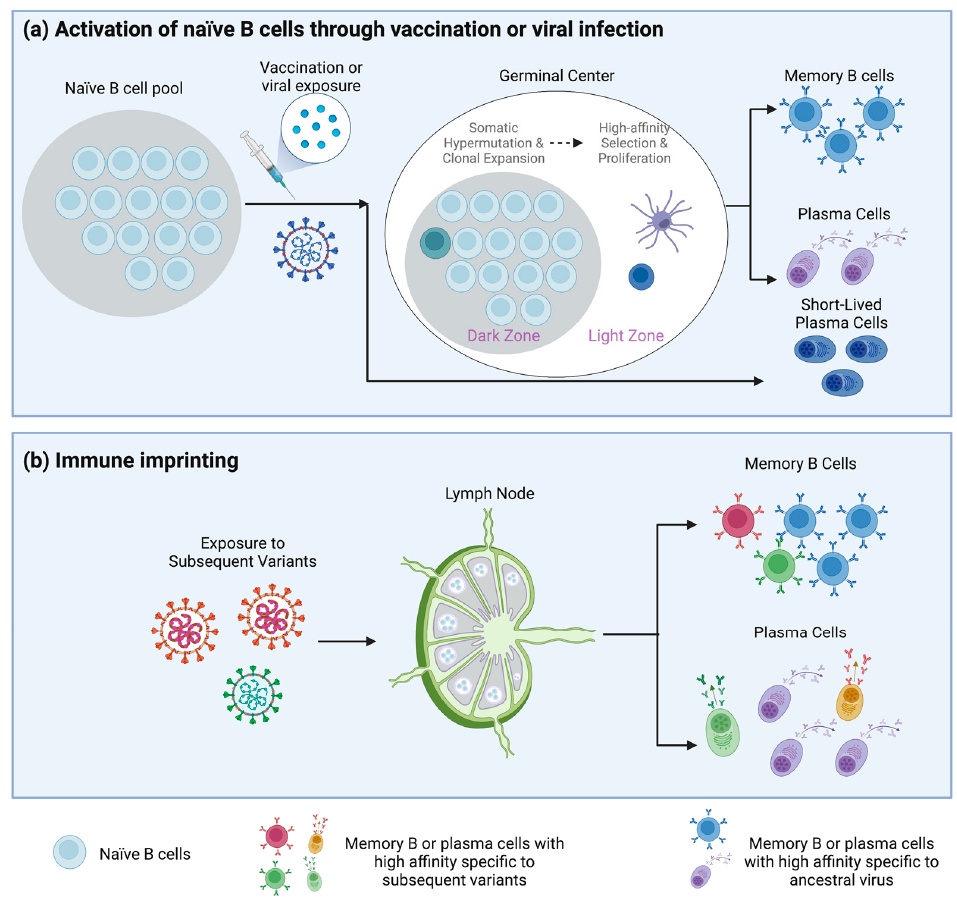
Figure 1. Establishment of B cell memory and immune imprinting. ( a ) Activation of memory B cells through vaccination or viral infection. Upon exposure to viral antigens by vaccination or infection, a germinal center starts to form. In the dark zone of the germinal center, optimal B cells with high-affinity BCR expressed on the surface can be selected for clonal expansion with the help of T FH cells and differentiate into long-term memory B cells and plasma cells. Some B cells can rapidly differentiate into short-lived plasma cells with low-binding affinity that are formed in the extrafollicular sites of secondary lymphoid organs. ( b ) The impact of immune imprinting on humoral immunity. In the presence of subsequent viral variants, the lymph nodes that have previously generated memory cells after exposure to ancestral viral antigens tend to produce a relatively higher number of memory B cells expressing antibodies against the ancestral virus compared to the B cells targeting the viral variants. (Created with BioRender.com).